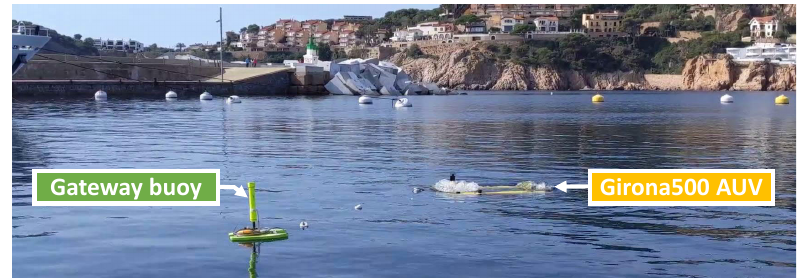
Figure 13. Girona500 AUV during the implementation of the path following algorithm at the harbor of Sant Feliu de Guíxols (Girona, Spain).